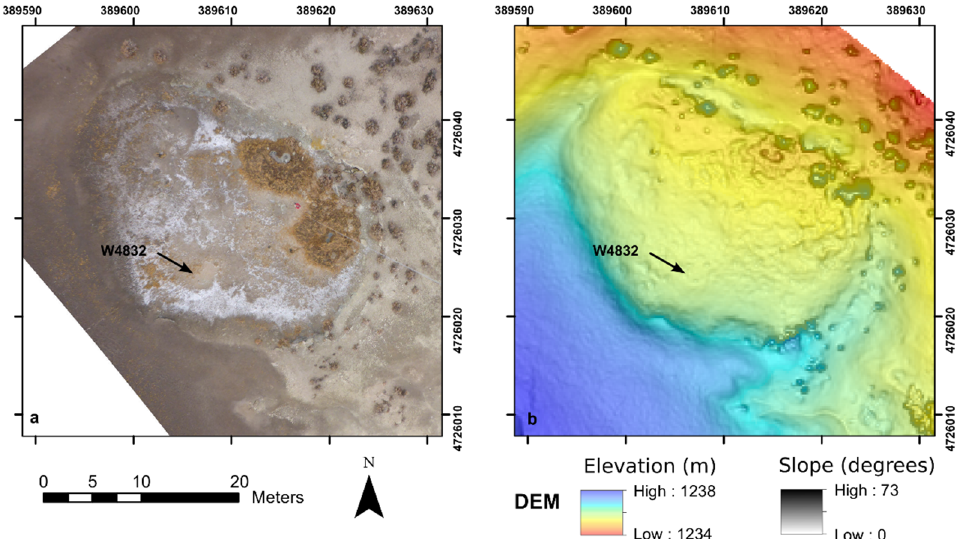
Figure 8. ( a ) Aerial photo of the broad depression of feature D1. ( b ) Elevation model of feature D1 showing a relatively sharp interior slope of the depression. Apron surrounding the depression gradually slopes away from the depression where sinter is exposed (northeast portion) and is relatively horizontal where blanketed with fine-grained silt and clay (southwest portion). Pool-edge sinter outcrops at high-slope areas around the edge of the